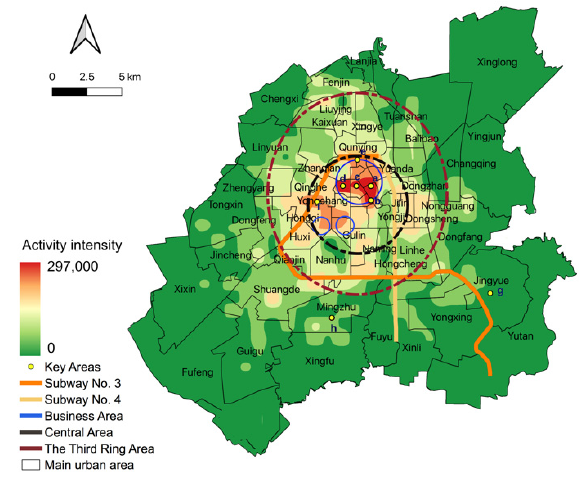
Figure 5. Spatial distribution of existing population activity intensity.